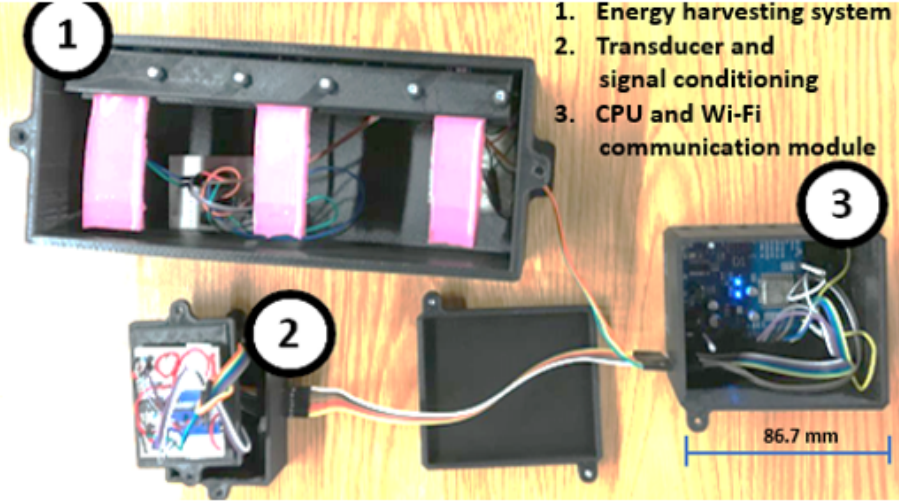
Figure 15. Complete manufactured smart-sensor